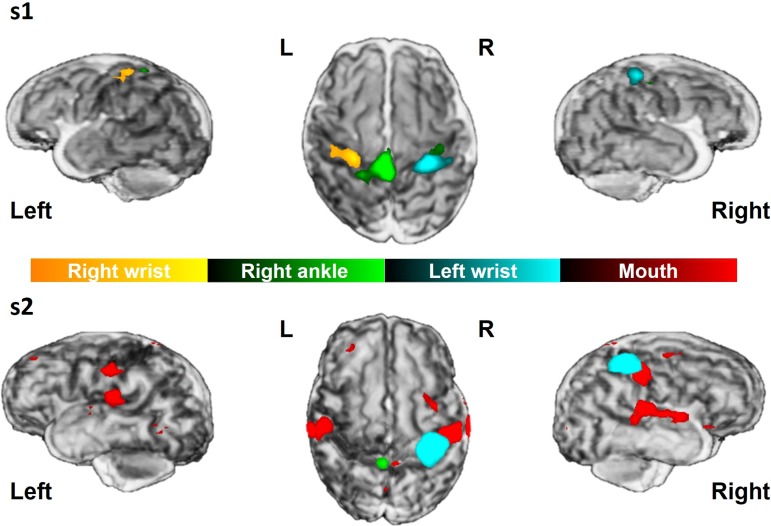
Representative functional responses in two subjects scanned at 33 + 6 weeks PMA (s1) and 35 + 3 weeks (s2). Single subject results show distinct significant clusters of functional activation (thresholded at z = 2.3) following stimulation of different body parts overlaid on the subject’s own 3D rendered T2-weigthed image.